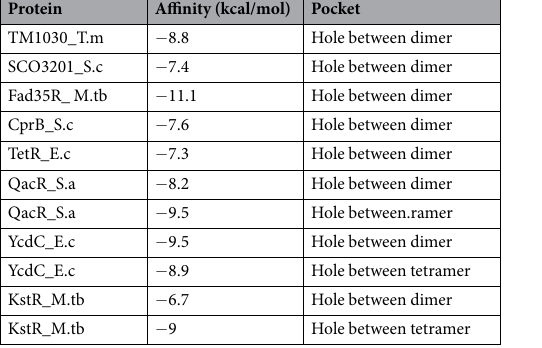
Table 2. The model data list of docking of c-di-GMP to the TetR family proteins from types of microorganism. T.m = Thermotoga maritime , S.c = Streptomyces coelicolor , E.c = Escherichia coli , S.a = Streptomyces coelicolor , M.tb = Mycobacterium tuberculosis